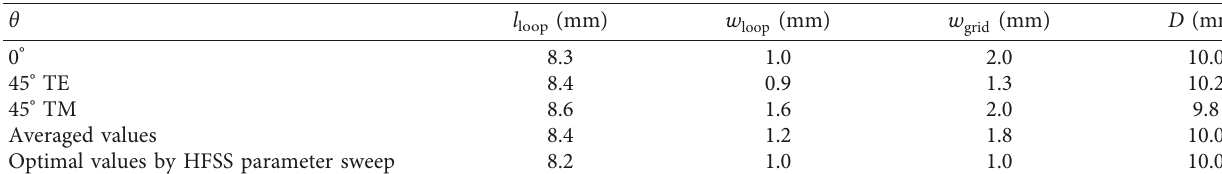
Table 2: Geometrical parameters calculated by the curve-fitting method.